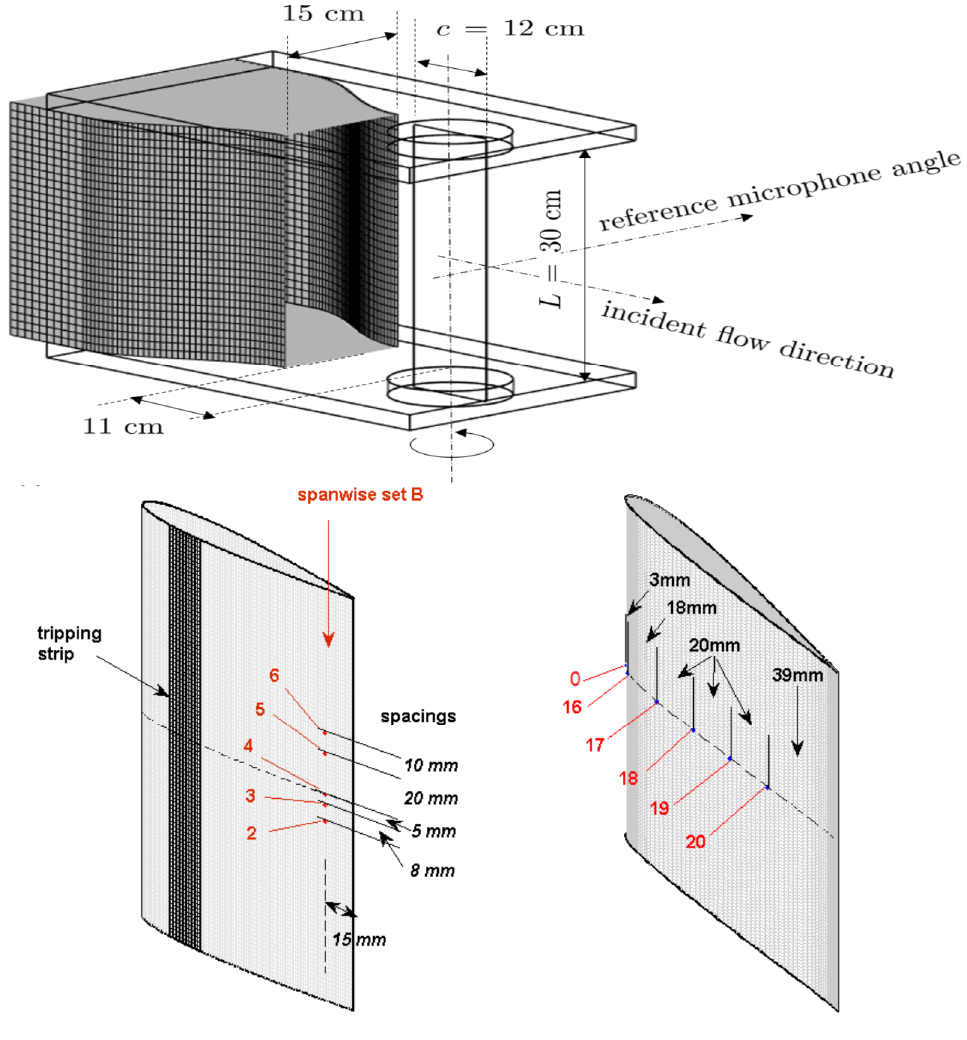
Figure 6. Sketch of the experimental setup used by Yakhina et al. [15] illustrating pin-hole locations and probe labels of the wall-pressure Remote Microphone Probes (RMP) on the NACA-0012 (bottom left) and SD7003 (bottom right) mock-up.